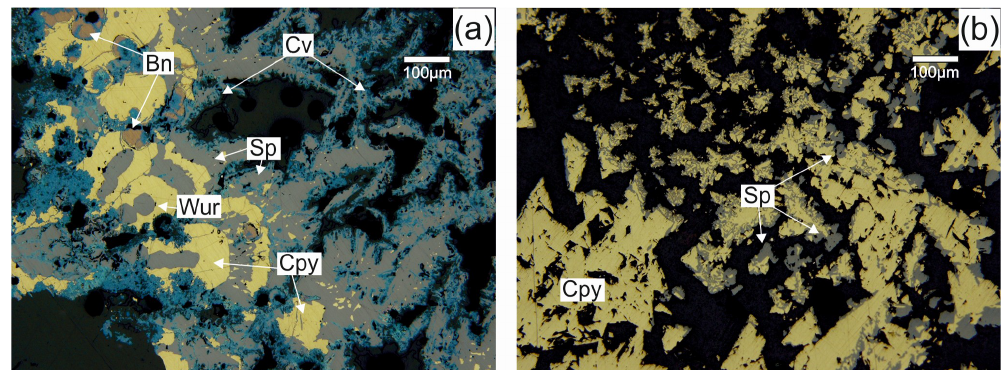
Figure 5. Reflected light photographs. ( a ) Rhythmic-layered texture of chalcopyrite (Cpy)-Zn-sulphides (sphalerite Sp, wurtzite Wur) aggregates. Wurtzite crystals are observed in the central part. Bornite (Bn) overgrows chalcopyrite (Cpy). Covellite (Cv) replaces sulphide minerals along fissures and overgrows Zn-sulphides (277-T-4); ( b ) “Graphic” intergrowths of sphalerite (Sp) and chalcopyrite (Cpy) in active chimneys